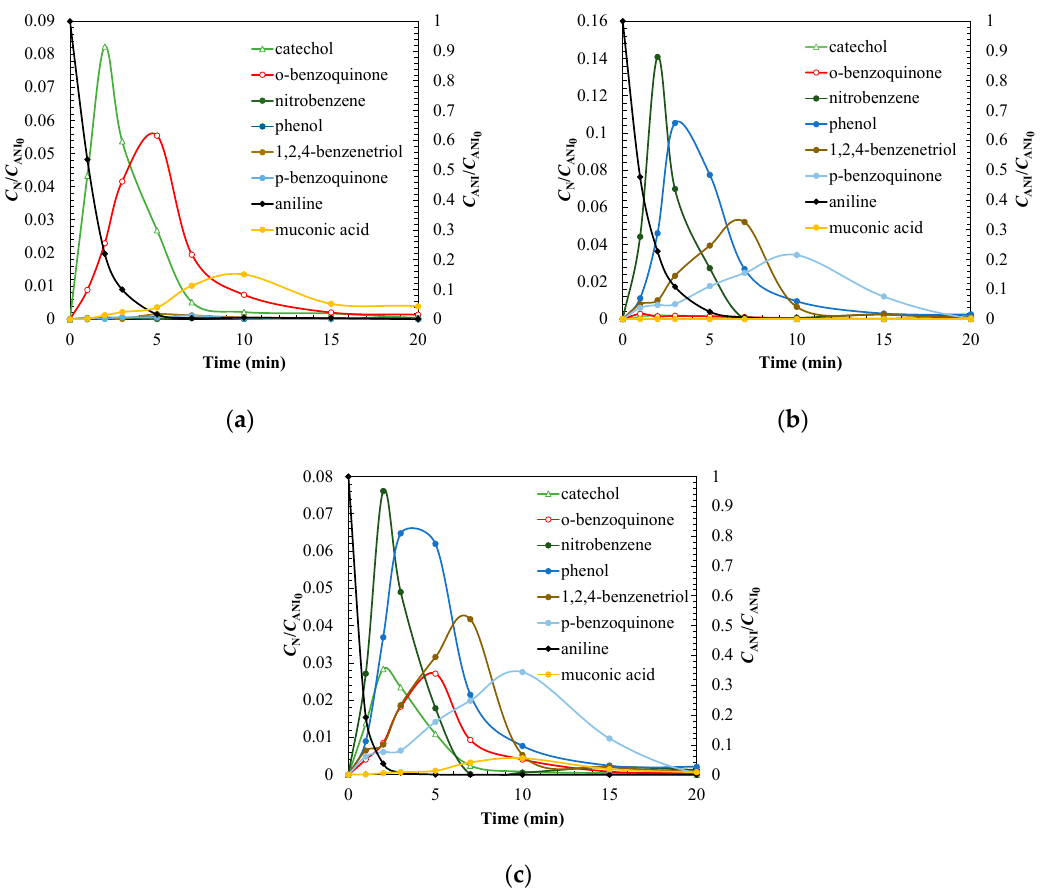
Figure 7. Analysis of the main intermediates in the aniline catalytic ozonation with TiO 2 /GAC excluding oxalic and oxamic acid in different cases: ( a ) molecular attack of ozone at pH = 3.0, ( b ) ozone in excess and dominance of radicalary attack (pH = 7.0 and ozone dose of 20.1 mg L − 1 ), and ( c ) most favourable conditions (pH = 7.0, 5.4 mg L − 1 ozone concentration) or combined molecular radicalary attack. Experimental conditions: Q G = 4 L min − 1 ; M CAT = 3.3 g L − 1 ; T = 18.0 °C; P = 1 atm; V reac = 1.5 L;